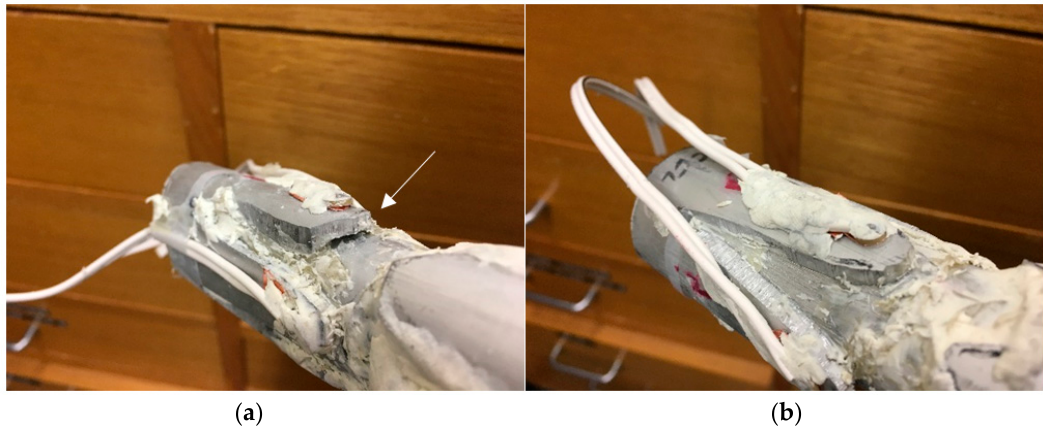
Figure 18. Triangular cross section of ( a ) Near: inadequate bonding and ( b ) Far: successfully